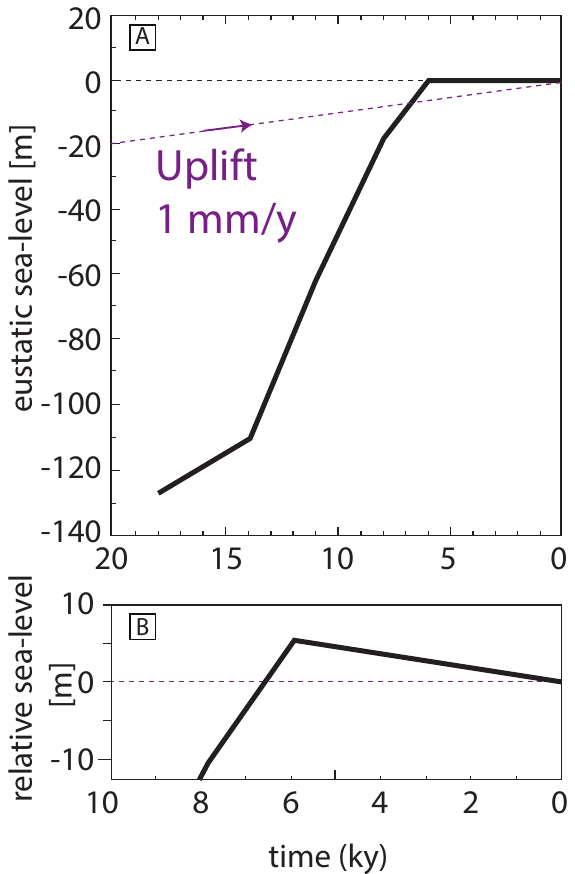
Figure 2. Simplified sea-level curve for the Holocene. ( A ) Eustatic sea-level curve of Lambeck [55] for the Oman Sea (Muscat). The purple line represents an uplift of 1 mm / year. ( B ) Holocene relative sea-level changes on a coast uplifting at 1 mm / year, a value considered reliable for the studied segment of the Makran coast [19].